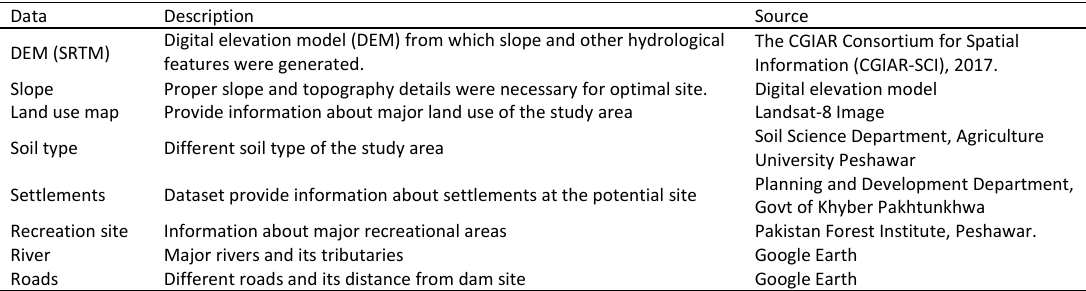
Table 1: Description of acquired data and their sources Table 1. Description of acquired data and their